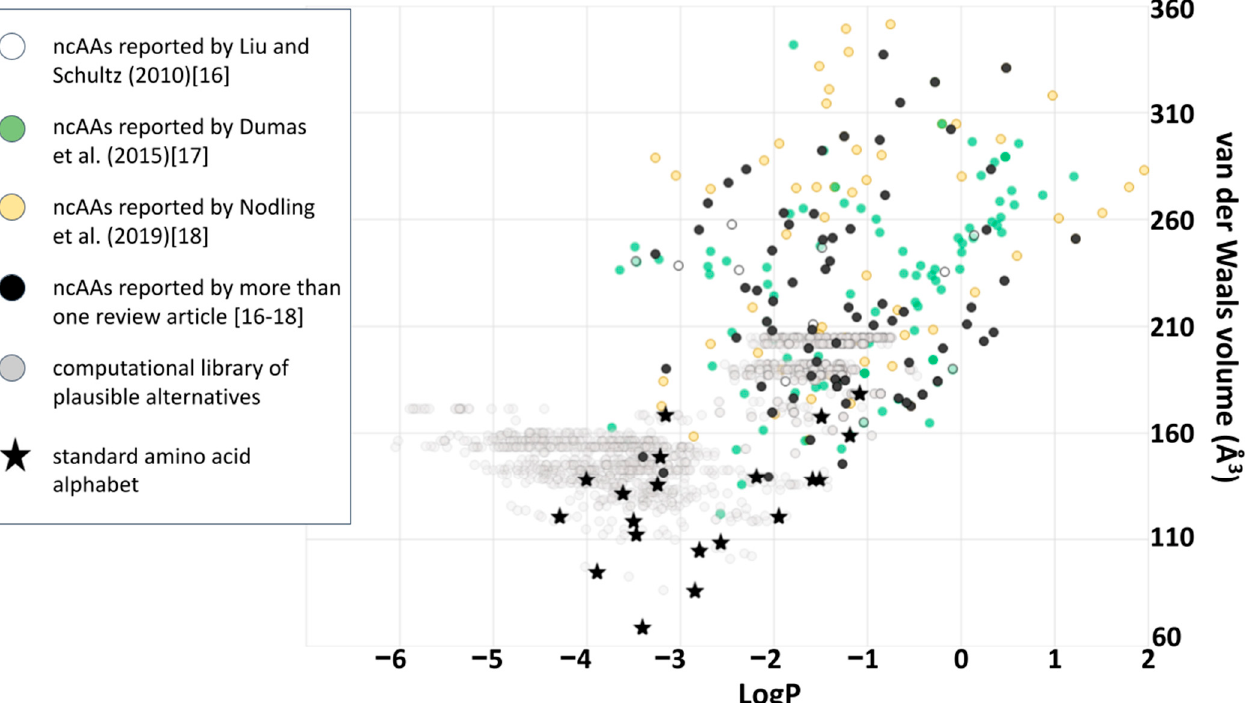
Figure 7. Genetically encoded amino acids as a small subset of chemically plausible alternatives. A comparison of ncAA’s (colored circles, sources and data as per Figure 2) with the computational library of 1913 amino acids used to derive results shown in Figure 4C,D and the 20 amino acids of the standard amino acid alphabet (see also Figure 6).